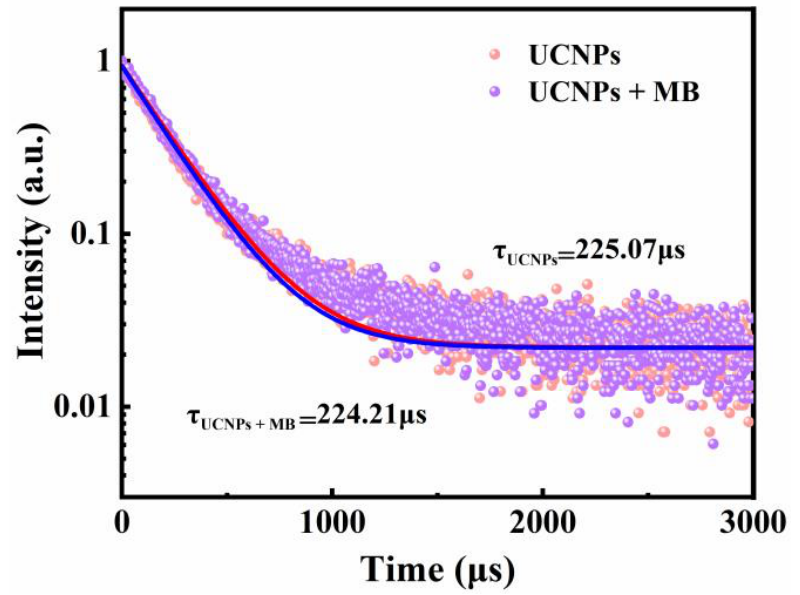
Figure 3. Fluorescence lifetime spectra of UCNPs and UCNPs + MB.